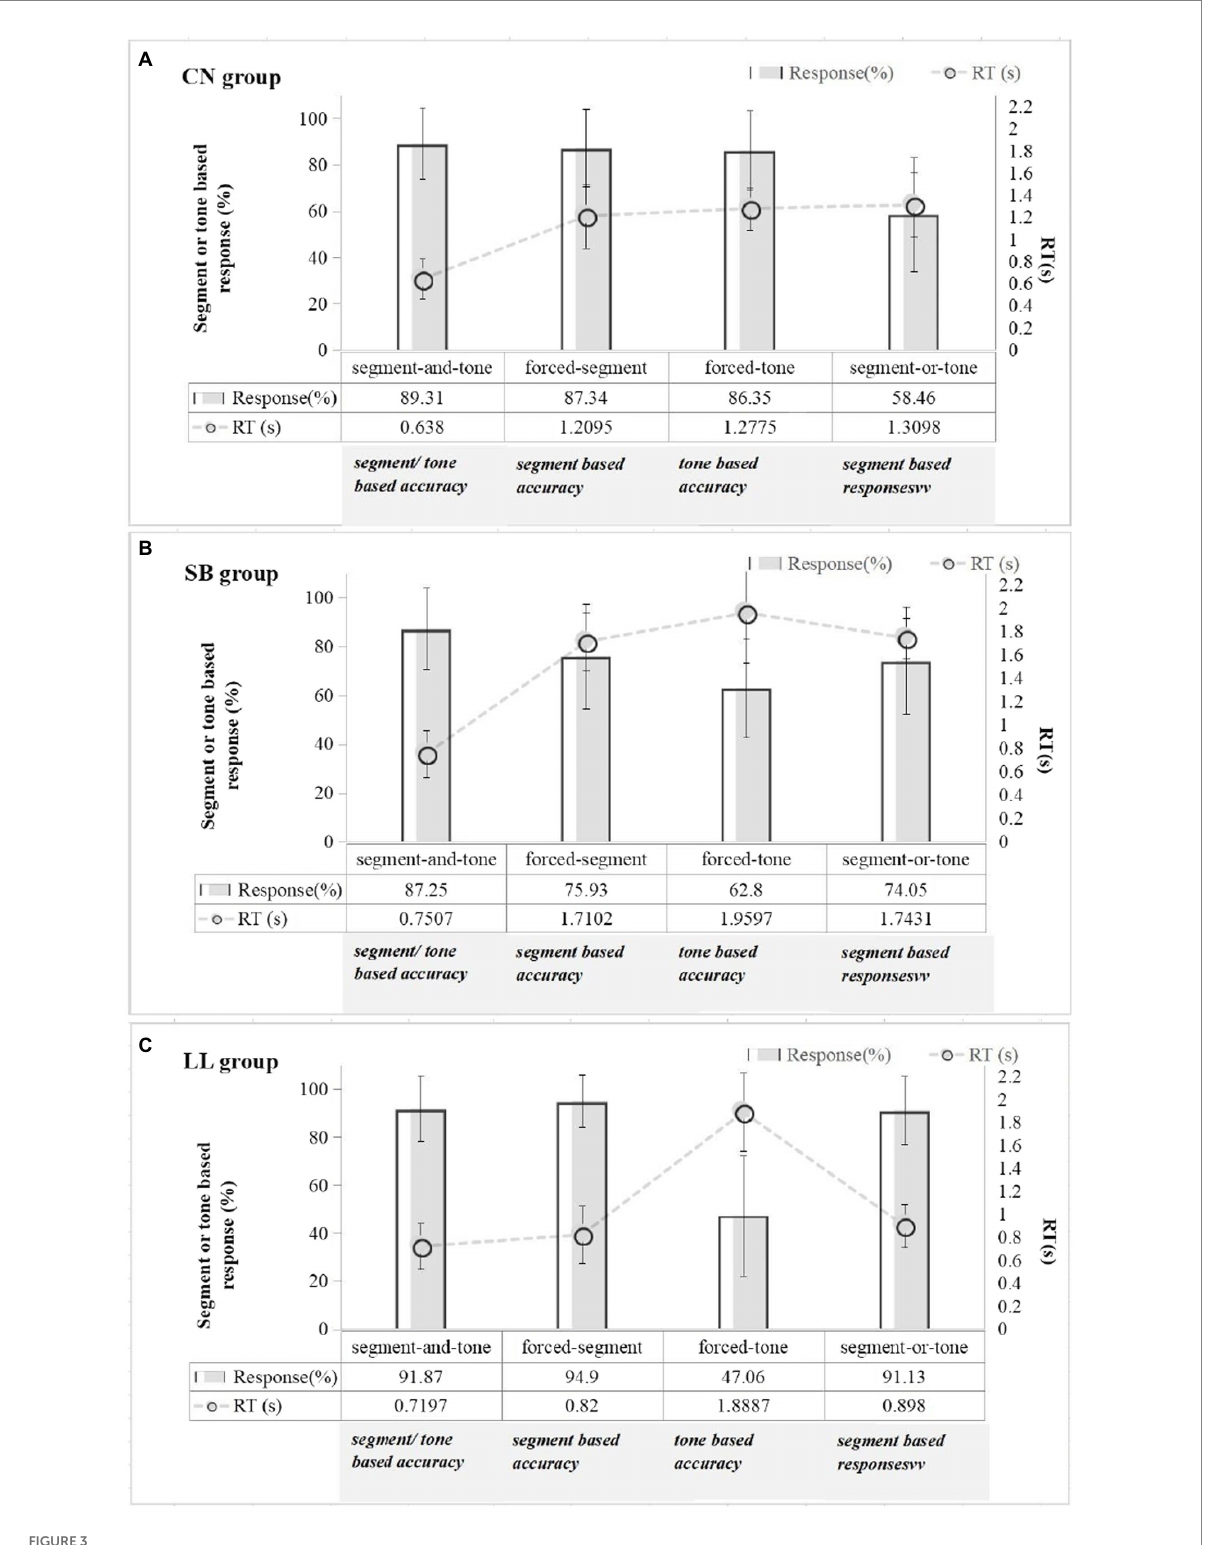
FIGURE 3 Responses and reaction time for the CN (A) , SB (B) , and LL (C) groups in the forced-segment, forced-tone, segment-and-tone, and segment-or-tone conditions. For the first three conditions, mean values of accuracy were exhibited, and for the last condition, mean response rate in segment was illustrated. For reaction time, 5 times of standard deviation is illustrated with error